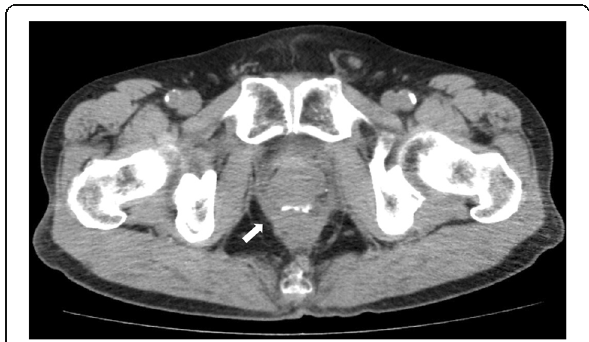
Fig. 4 Computed tomography scan 3 months before the patient presented with symptoms of a leak shows a circumferential staple line at the anastomotic